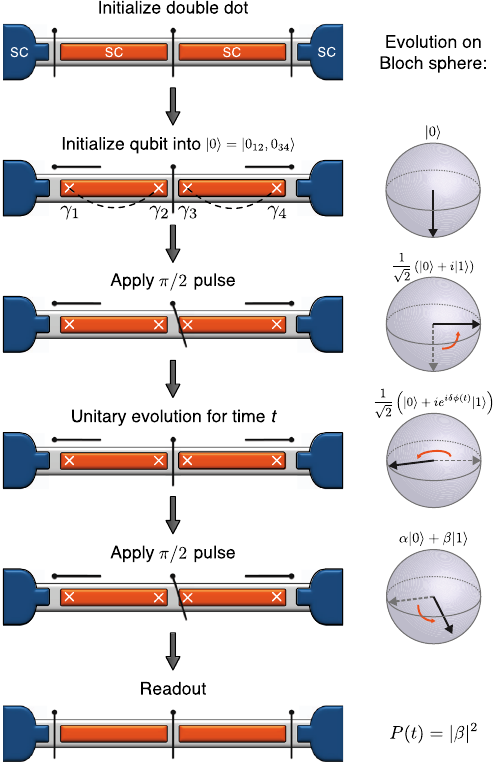
FIG. 10. Protocol for measuring the topological qubit ’ s dephas- ing time T 2 and oscillation frequency ω 0 . The left side illustrates the valve manipulations while the right shows the corresponding qubit orientation on the Bloch sphere. After initialization and a π = 2 pulse, the qubit unitarily evolves for time t . During this evolution, the relative phase between j 0 i and j 1 i changes by an amount δϕ ð t Þ set by ω 0 and time-dependent noise in the splitting of the qubit states. Crucially, the latter two factors are intimately related for the topological qubit because they are constrained by the same exponential suppression. After a second π = 2 pulse, the probability of measuring the j 1 i state is P ð t Þ ¼ j β j 2 ¼ 1 1 þ cos δϕ ð t Þ(cid:2) . Noise averaging gives Eq. (29), which simulta- 2 ½ neously probes both T 2 and ω 0 . The nontrivial connection between uniform quantities and fluctuations for the topological qubit implies the unusual scaling relation between ω 0 and 1 =T 2 in Eq. (31) that signifies topological protection. A similar scaling relation links T 1 and T 2 ; see Eq.